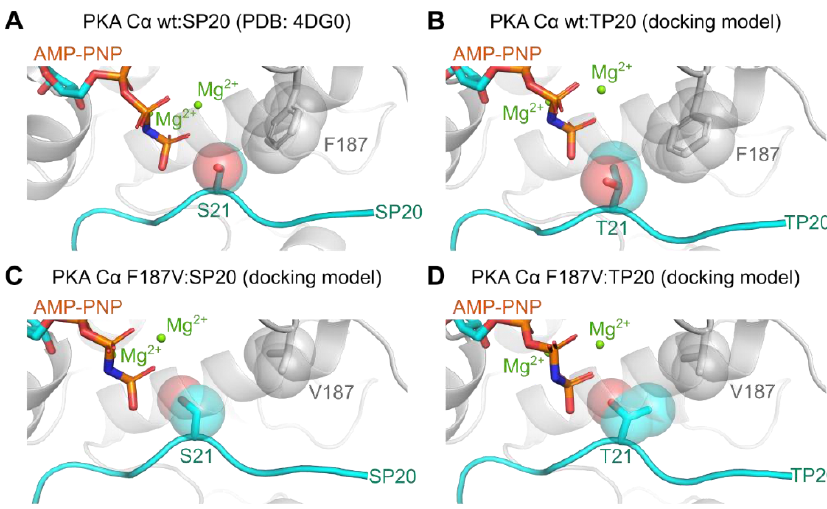
Figure 5. The Ser/Thr specificity of PKA is determined by the DFG+1 motif. ( A ) The binding pocket of PKA Cα in complex with AMP-PNP, Mg 2+ , and SP20 (PDB code: 4DG0) [25]. The DFG+1 phenylalanine (F187) occupies a large space directly adjacent to the P0 site, coordinating the SP20 serine at this position. ( B – D ) Model structures derived from docking simulations performed with YASARA (v.18.12.27) [41,52]. ( B ) The hydroxyl group of the threonine at the P0 site (T21 in TP20) points away from the γ-phosphate due to the additional methyl group, which could hinder the phosphoryl transfer. ( C ) In the case of the F187V mutation, the P0 serine can rotate more freely due to the smaller branched valine at the DFG+1 position. ( D ) The valine could allow a favorable orientation of the threonine at the P0 site for phosphoryl transfer. All structure images were generated using the PyMOL Molecular Graphics System (Version 2.2.2; Schrödinger, LLC, New York, NY, USA).